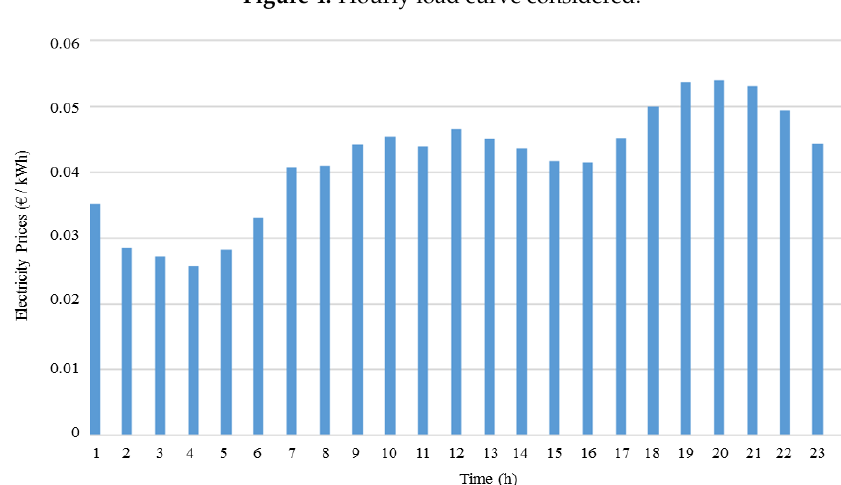
Figure 4. Hourly load curve considered.